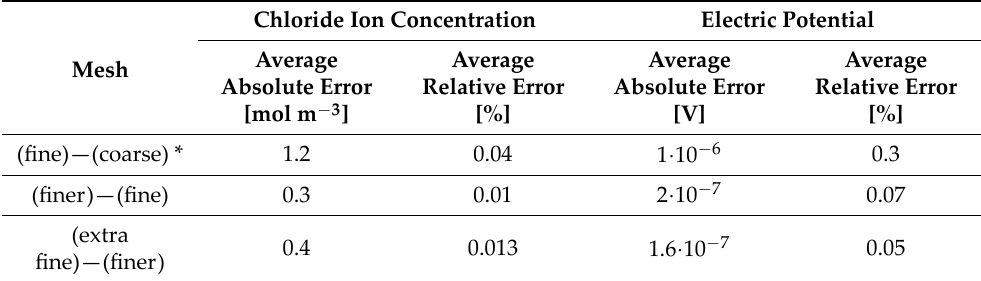
Table 7. Calculated chloride ion concentration and electrical potential average absolute and relative errors for representative time 660 h of the process, for different meshes (see Table 6). Chloride Ion Concentration Electric Potential Average Average Average Average Mesh Absolute Error Relative Error Absolute Error Relative Error [mol m − 3 ] [%] [V]